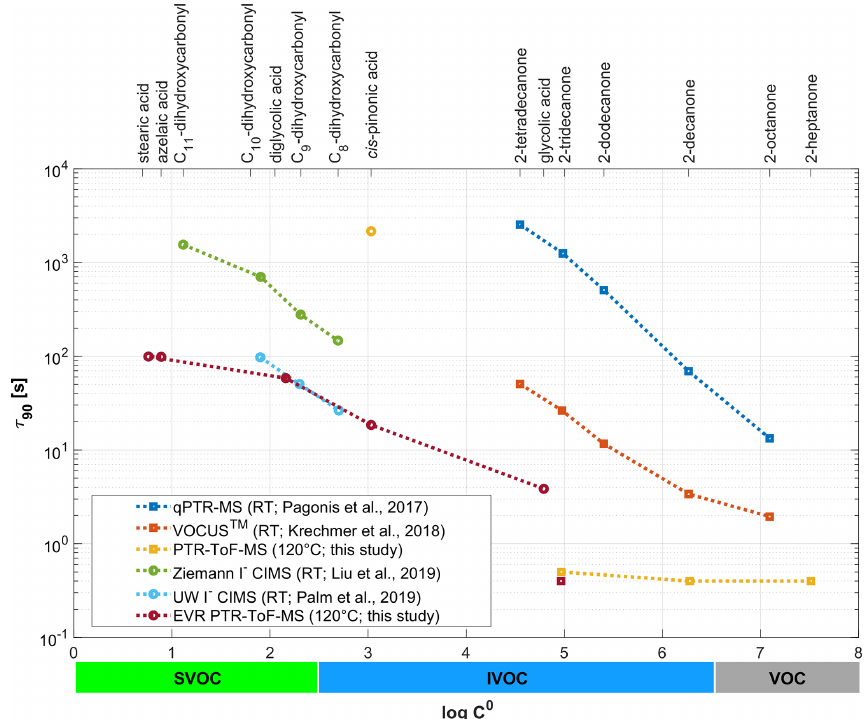
Figure 6. Signal decay times (here reported as τ 90 ) as observed in different online chemical ionization mass spectrometry (CIMS) instru- ments for a set of ketones, carboxylic acids and dihydroxycarbonyls. τ 90 is plotted as a function of the SIMPOL.1-derived saturation mass concentration (log C 0 ). Note that the figure legend shows the different operating temperatures of the instruments used (RT: room tempera-